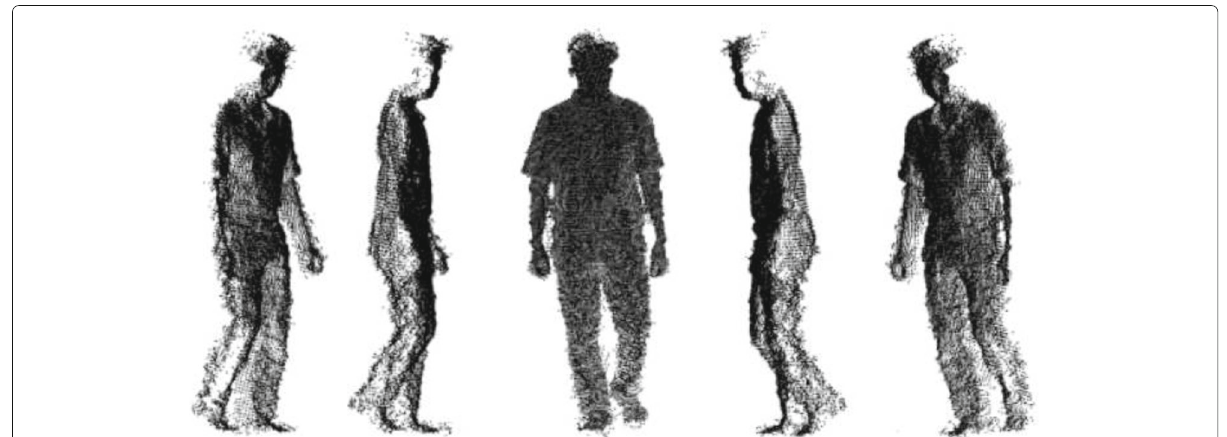
Fig. 2 The point cloud reconstructed from a depth map using the method [22]